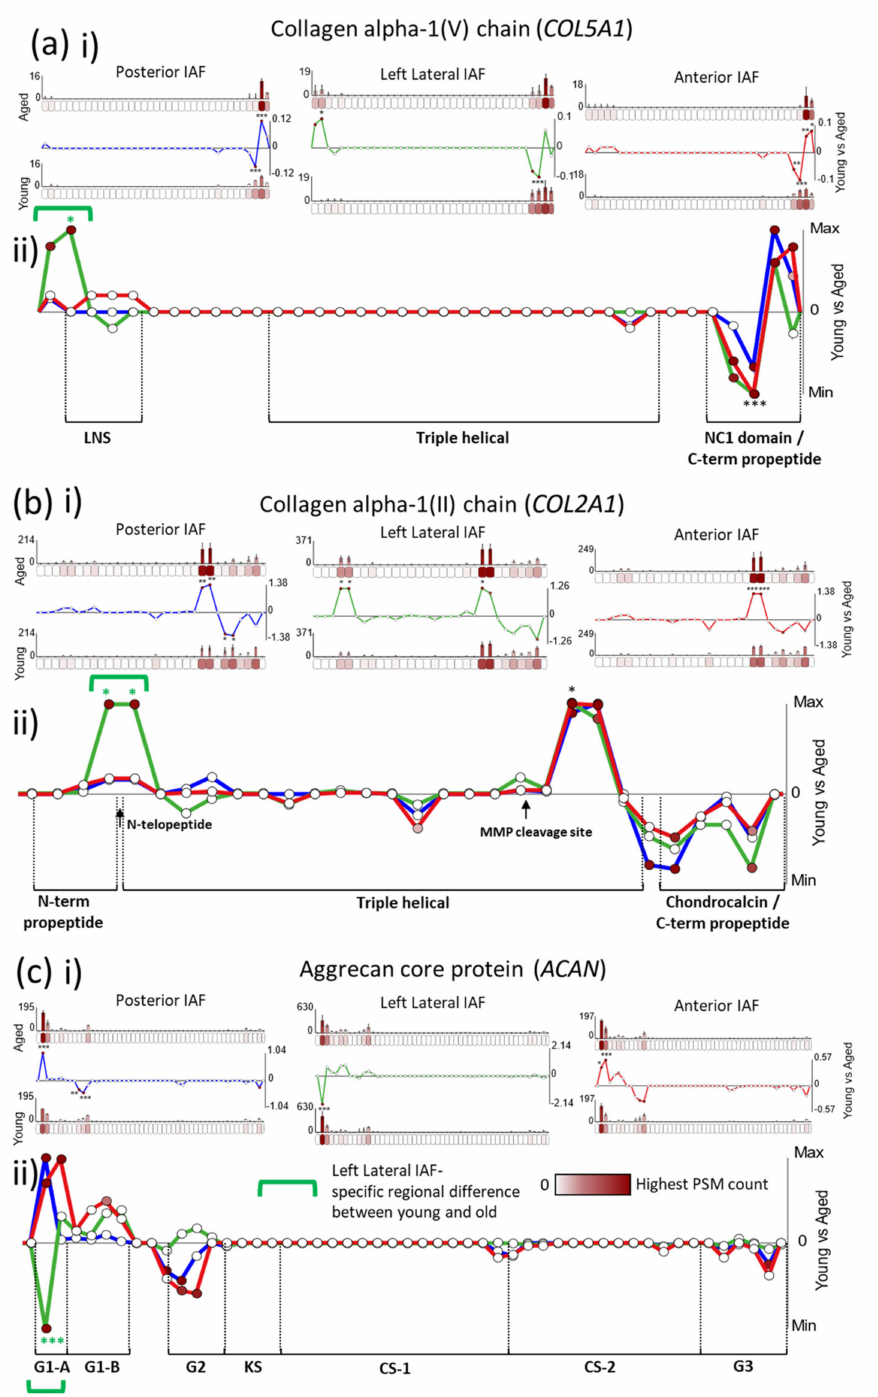
Figure 5. COL5A1 , COL2A1 and aggrecan all exhibit lateral, inner AF-specific differences in peptide yield not seen in the posterior or anterior IVD regions. PSMs were summed in each 50-aa protein segment, normalised and averaged for young and aged groups (bar graphs = average, normalised PSMs, error bars = standard deviation). Average PSMs per segment in the young group were subtracted by those in the aged one and divided by segment aa length (50) to reveal fluctuations in peptide yield along protein structures (line graph y axes = aged–young PSM counts/segment length, normalised between tissue regions in composite graphs; * p ≤ 0.05; ** p ≤ 0.01; *** p ≤ 0.001, Bonferroni-corrected, repeated-measures ANOVA; black * in composite line graph = significant in all three IVD regions; functional domains, sourced from UniProt, are indicated). (( a ), i) Several